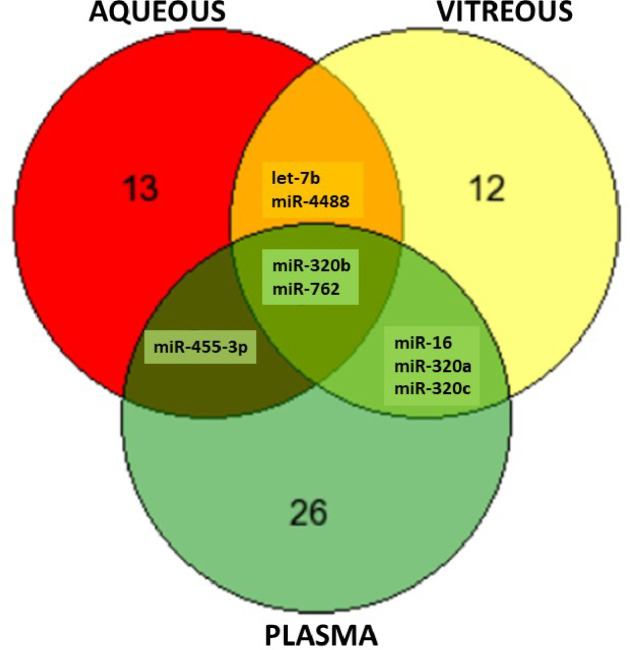
Summary venn diagram of the most promising microRNA biomarkers.